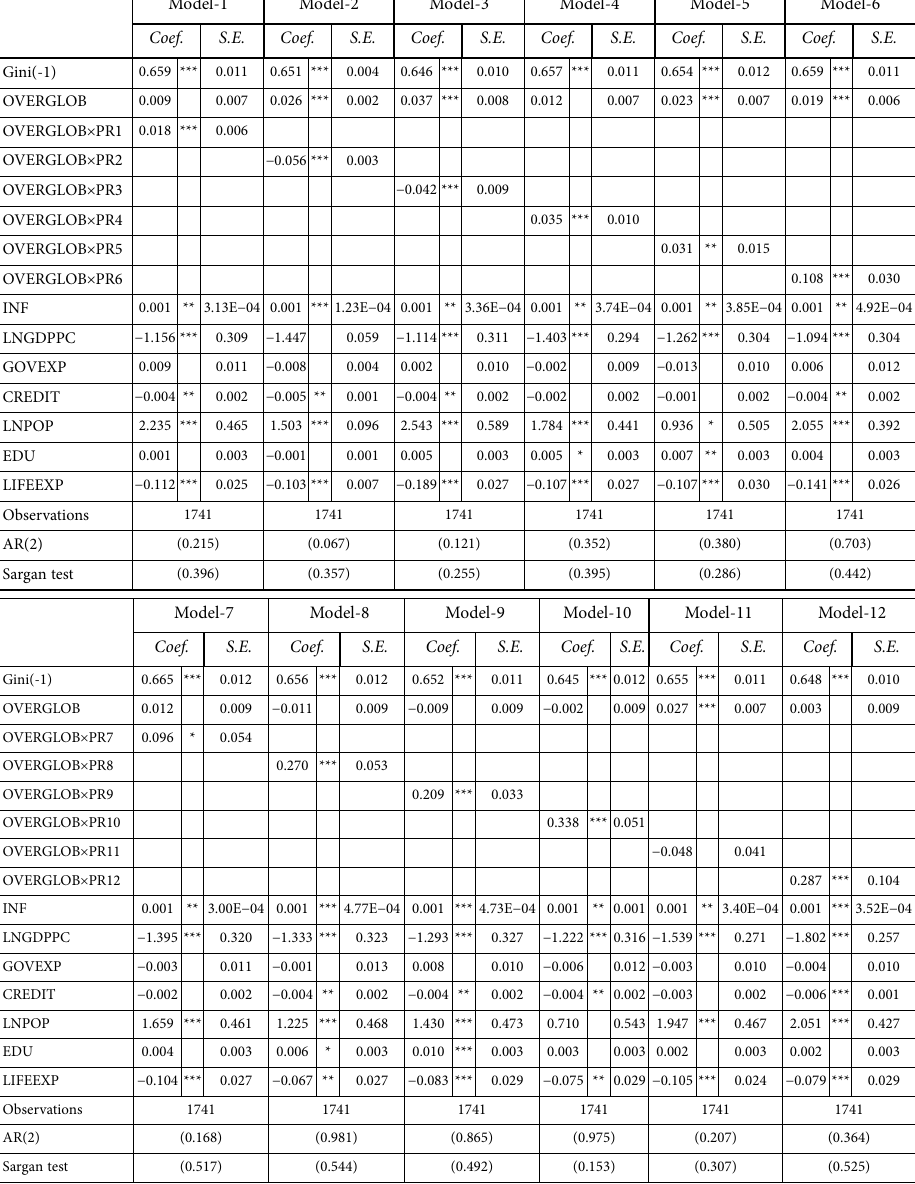
Table 8. The effects of globalization under sub-dimensions of political risk Model-1 Model-2 Model-3 Model-4 Model-5 Model-6 S.E. Coef. S.E. Coef.